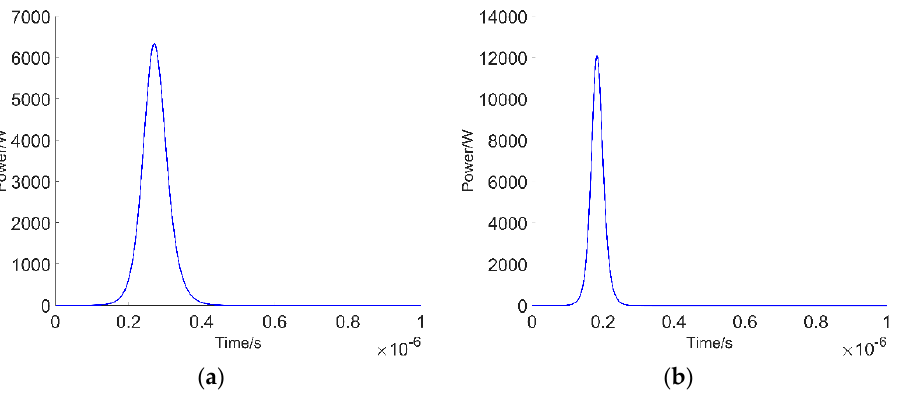
Figure 11. Numerically calculated dependence of the output power on time at T tr = 200 (ns) with the facet reflectivity for signal wave at z = L switched between 0.04 and 0.2 and pump power of 8 (W):